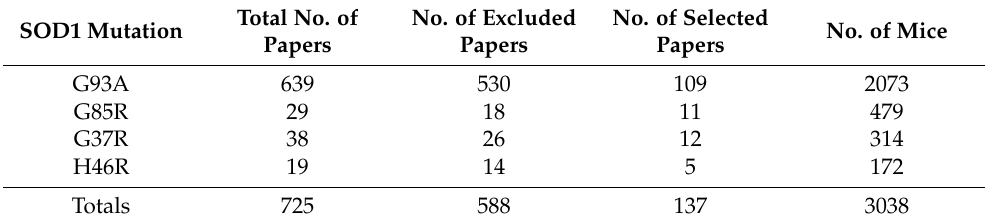
Table 1. Number of primary studies found by PubMed search, and selected for meta-analysis after application of inclusion criteria, with the corresponding number of mice used for incidence analysis. Total No. of No. of Excluded No. of Selected No. of Mice SOD1 Mutation Papers Papers Papers G93A 639 530 109 2073 G85R 29 18 11 479 G37R 38 26 12 314 H46R 19 14 5 172 Totals 725 588 137